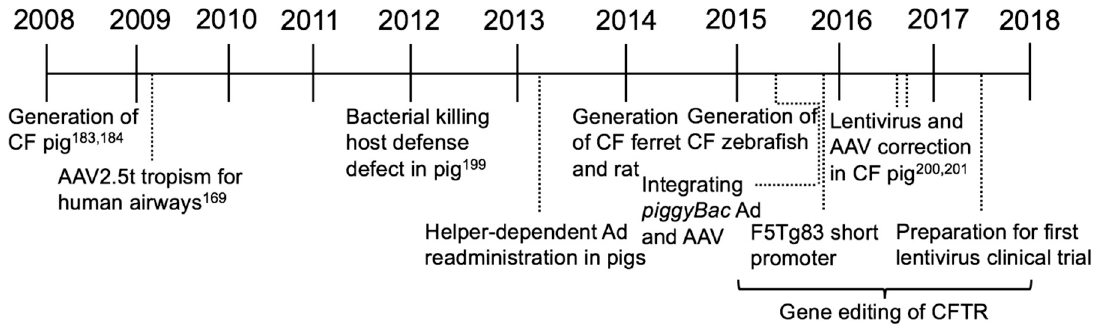
Figure 4. Important milestones for the third era of CF gene therapy (2008–2018).